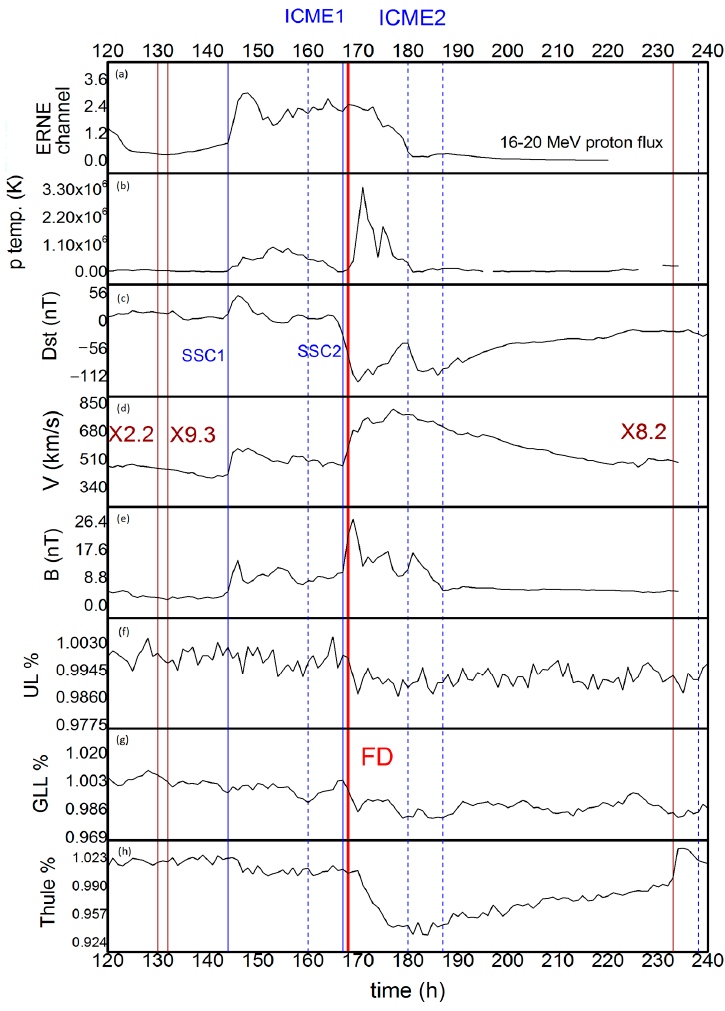
Figure 8. Hourly variation in CR intensity measured at ground station (( f ) UL, ( g ) GLL, ( h ) Thule), ( e ) magnitude of interplanetary magnetic field B, ( d ) velocity of solar wind V, ( c ) Dst index, ( b ) proton temperature, and ( a ) one of the proton channels measured by ERNE/SOHO during early September 2017 (period 4th–10th). Table 3. Statistical correlation (with significance) between time series of CR flux measured at ground stations and selected space weather parameters during 5–10 September 2017. Pearson